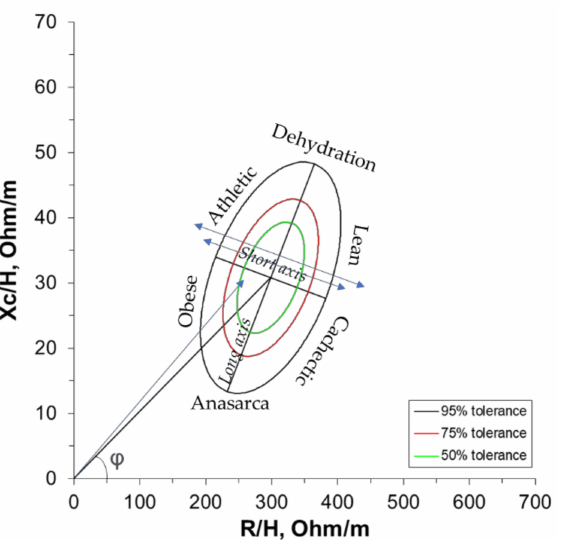
Figure 1. BIVA nomogram pattern, RXc-graph. Resistance (R) and reactance (Xc) were normalized by the height (H, meter) (adapted from Piccoli and Pastore,